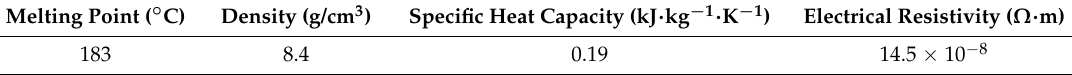
Table 1. Physical parameters of the solder wire.